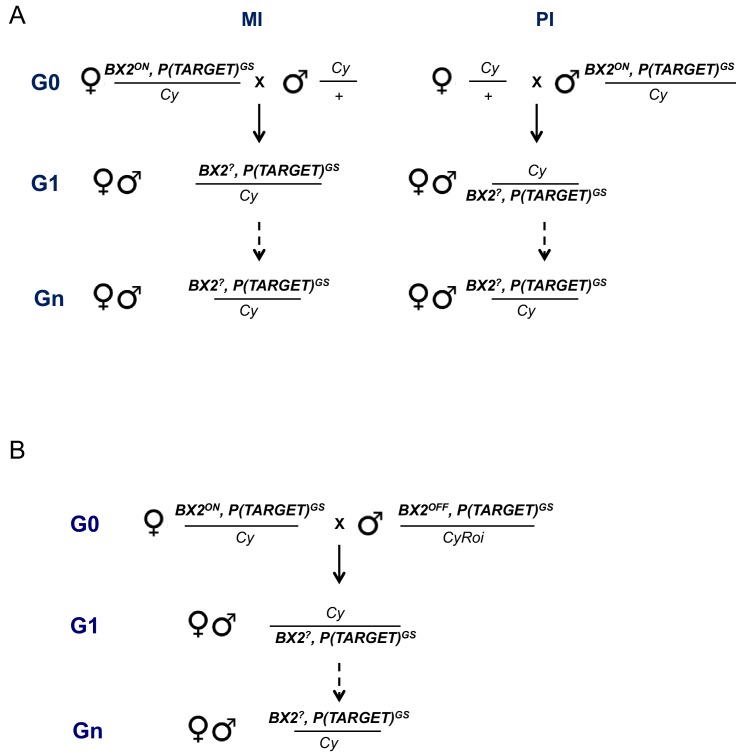
Maternal (A) and paramutagenic (B) effect of BX2ON lines.(A) Reciprocal crosses were performed at 25°C between BX2ON, P(TARGET)GS flies (either BX2Θ or BX2*) and flies carrying a balancer of the second chromosome (Cy). Lines were established with G1 individuals of maternal or paternal inheritance (named MI or PI, respectively) that carry the BX2, P(TARGET)GS chromosome, associated with white+ phenotype conferred by BX2 transgenes, over Cy and maintained at 25°C. Silencing capacities of these lines were tested over generations by ovarian ß-Galactosidase staining (Supplementary file 3). (B) The capacity of maternally inherited BX2ON piRNAs to activate a BX2OFF cluster was tested as shown on the mating scheme. BX2ON, P(TARGET)GS females (either BX2Θ or BX2*) were crossed at 25°C with BX2OFF, P(TARGET)GS males and lines were established with G1 individuals which maternally inherited piRNAs and paternally inherited the BX2 cluster. Lines were distinguished thanks to two distinct balancers, Cy and CyRoi that are devoid of transgenes and carrying different dominant markers. These lines were maintained at 25°C and their silencing capacities were tested over generations by intra-strain ovarian ß-Galactosidase staining (Supplementary file 4).